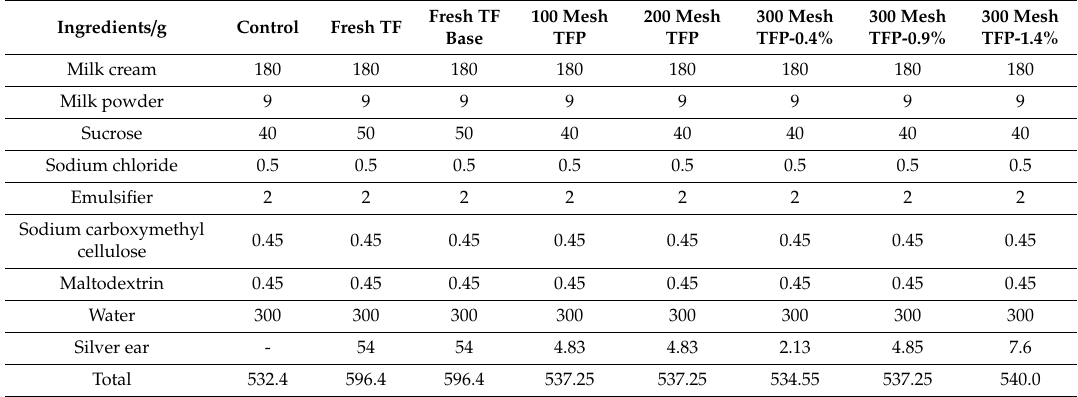
Table 1. Tremella fuciformis ice cream